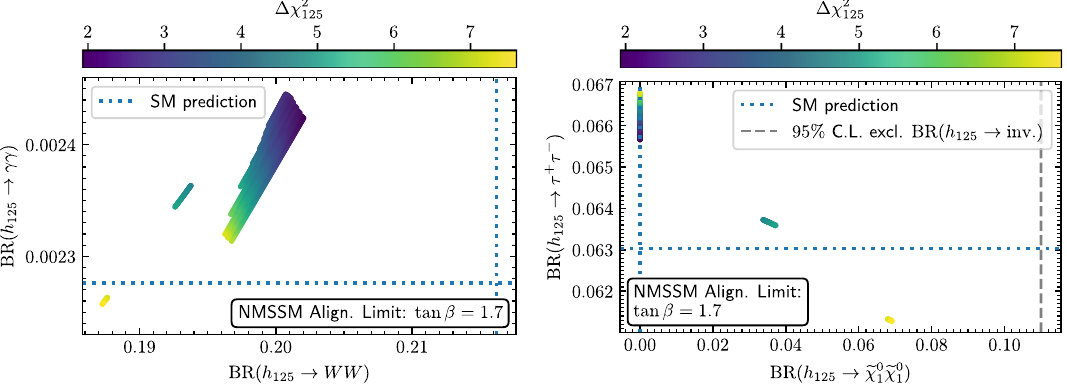
Fig. 22 NMSSM parameter points with χ 2 ≤ χ 2 BR ( h 125 → WW ∗ ) –BR ( h 125 → γγ) (left) and BR ( h 125 → (cid:16) χ 0 BR ( h 125 → τ + τ − ) (right). The colors of the points indicate the val-